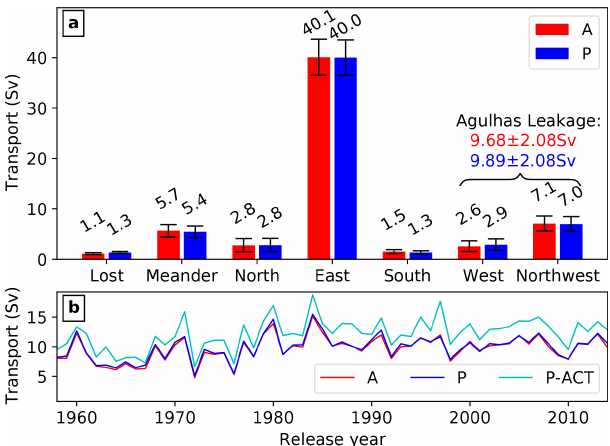
Figure 2. (a) Mean (1958–2014) transport across all sections as shown in Fig. 1 for experiment A in red and P in blue. The transport of all particles not crossing any section is shown as “Lost” and the transport of all particles leaving the region by crossing the release section again is shown as “Meander”. (b) Time series of the Agulhas leakage transport for A (red), P (blue) and P-ACT